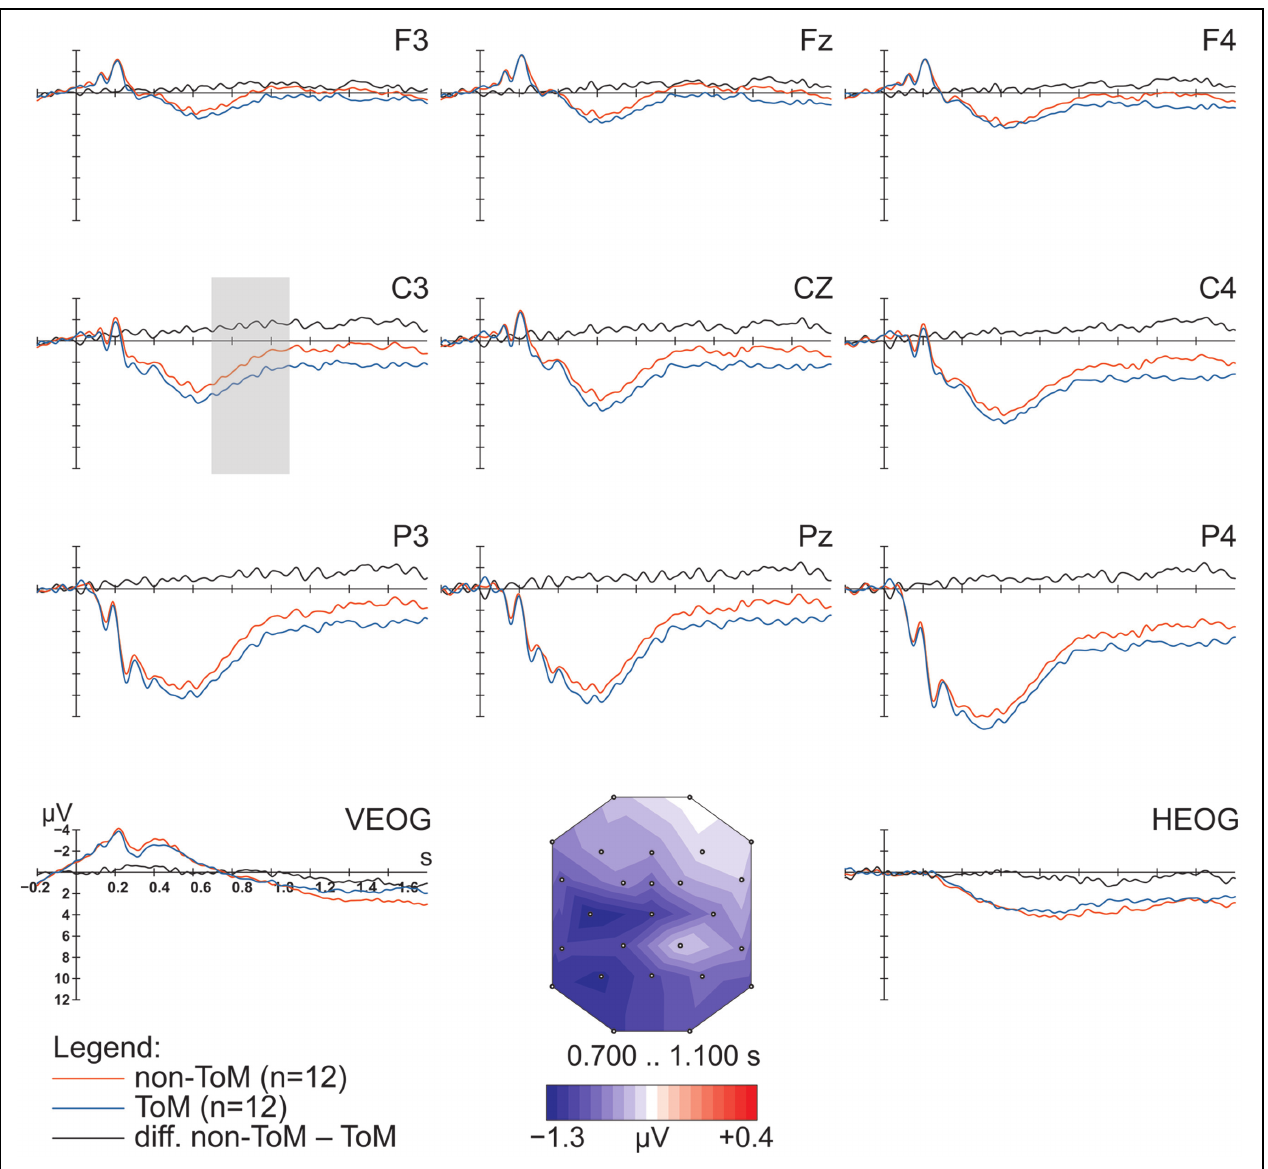
FIGURE 4 | Grand-average ERP waveforms, referenced to the nose, elicited at nine scalp electrodes and two EOG channels in response to the onset of an abstract art image, time-locked to picture onset. Illustrated are waveforms for the two conditions (non-ToM, ToM) and the difference wave (non-ToM − ToM). The time interval used to plot the voltage map is indicated by a gray shade (shown at electrode with highest mean amplitude difference). The voltage map represents the difference between the non-ToM and ToM condition during the time interval 0.700 to 1.100 s after picture